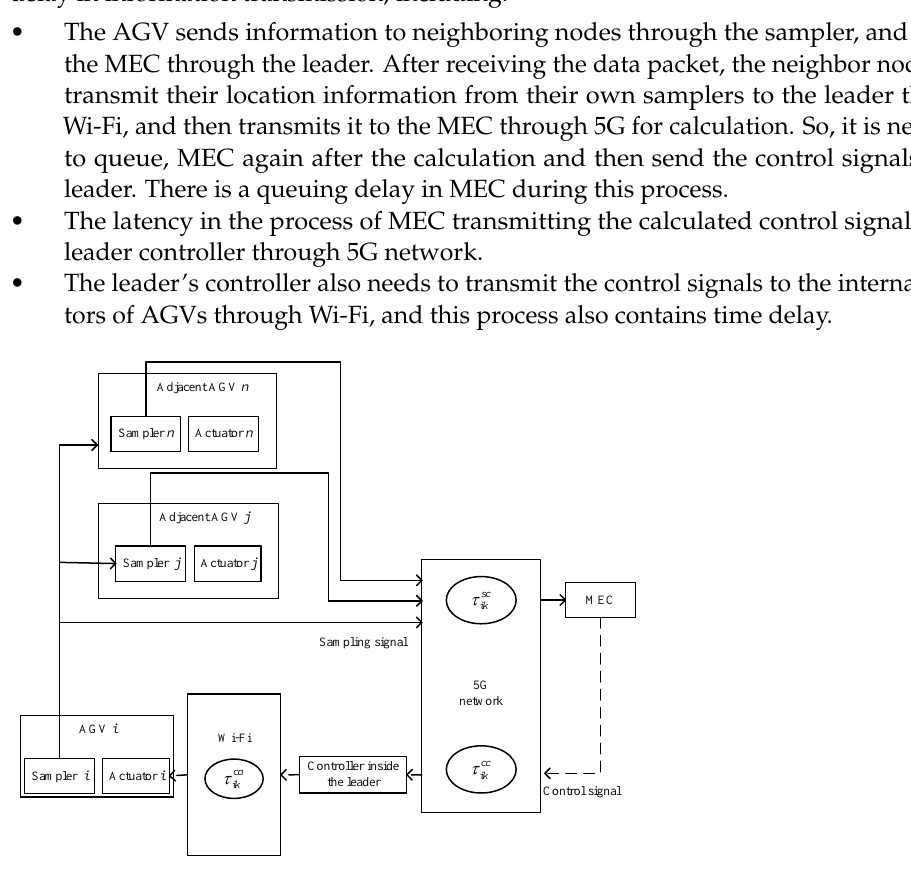
Figure 2. Control process structure of multi-AGV cooperative system.The time delay of signal transmission is analyzed. The ellipse represents the time delay that occurs during the process. Solid arrows represent sampling signals and dotted arrows represent control